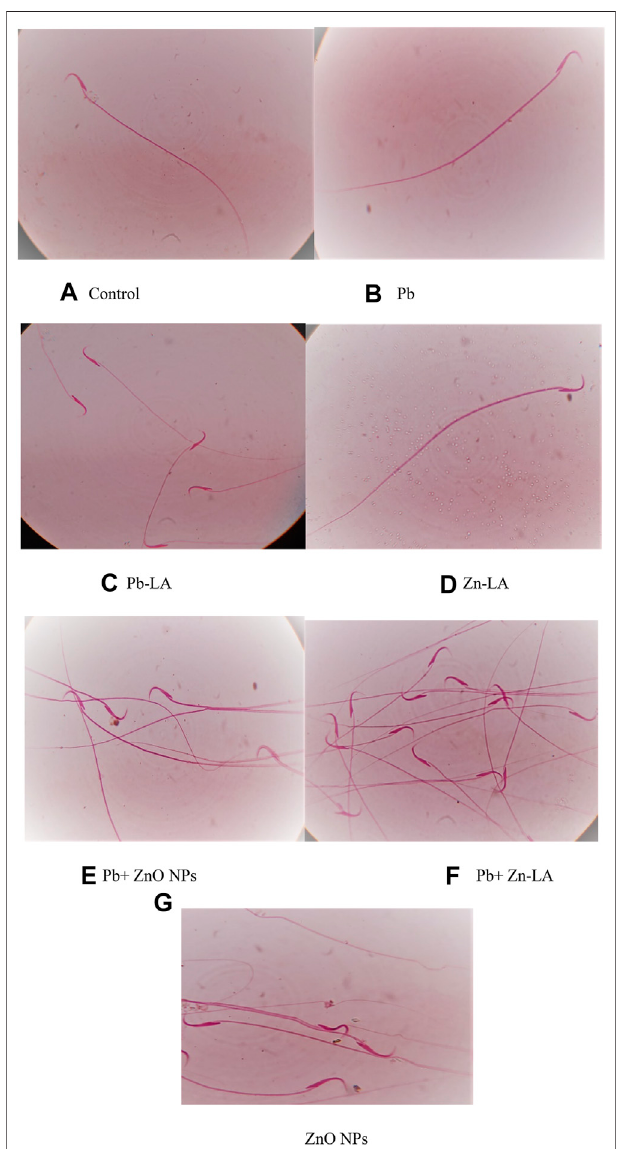
FIGURE8| Effectoflipoicacidonlead-andzincoxidenanoparticles – altered sperm morphology. The normal morphology of sperms was shown in fi gures (A – F) . The morphological abnormalities were indicated by arrows (G) .